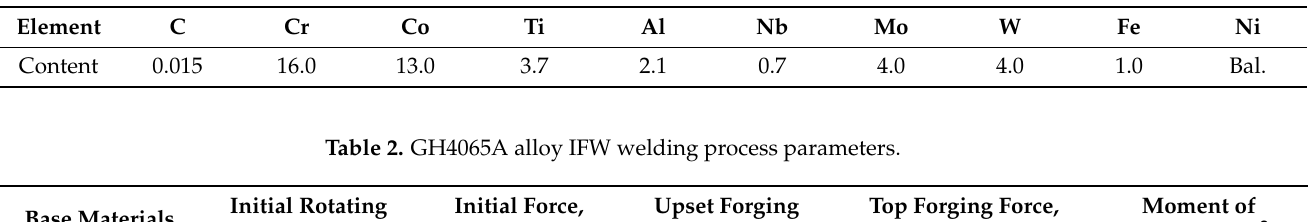
Table 1. Chemical compositions of GH4065A alloy (wt.%).